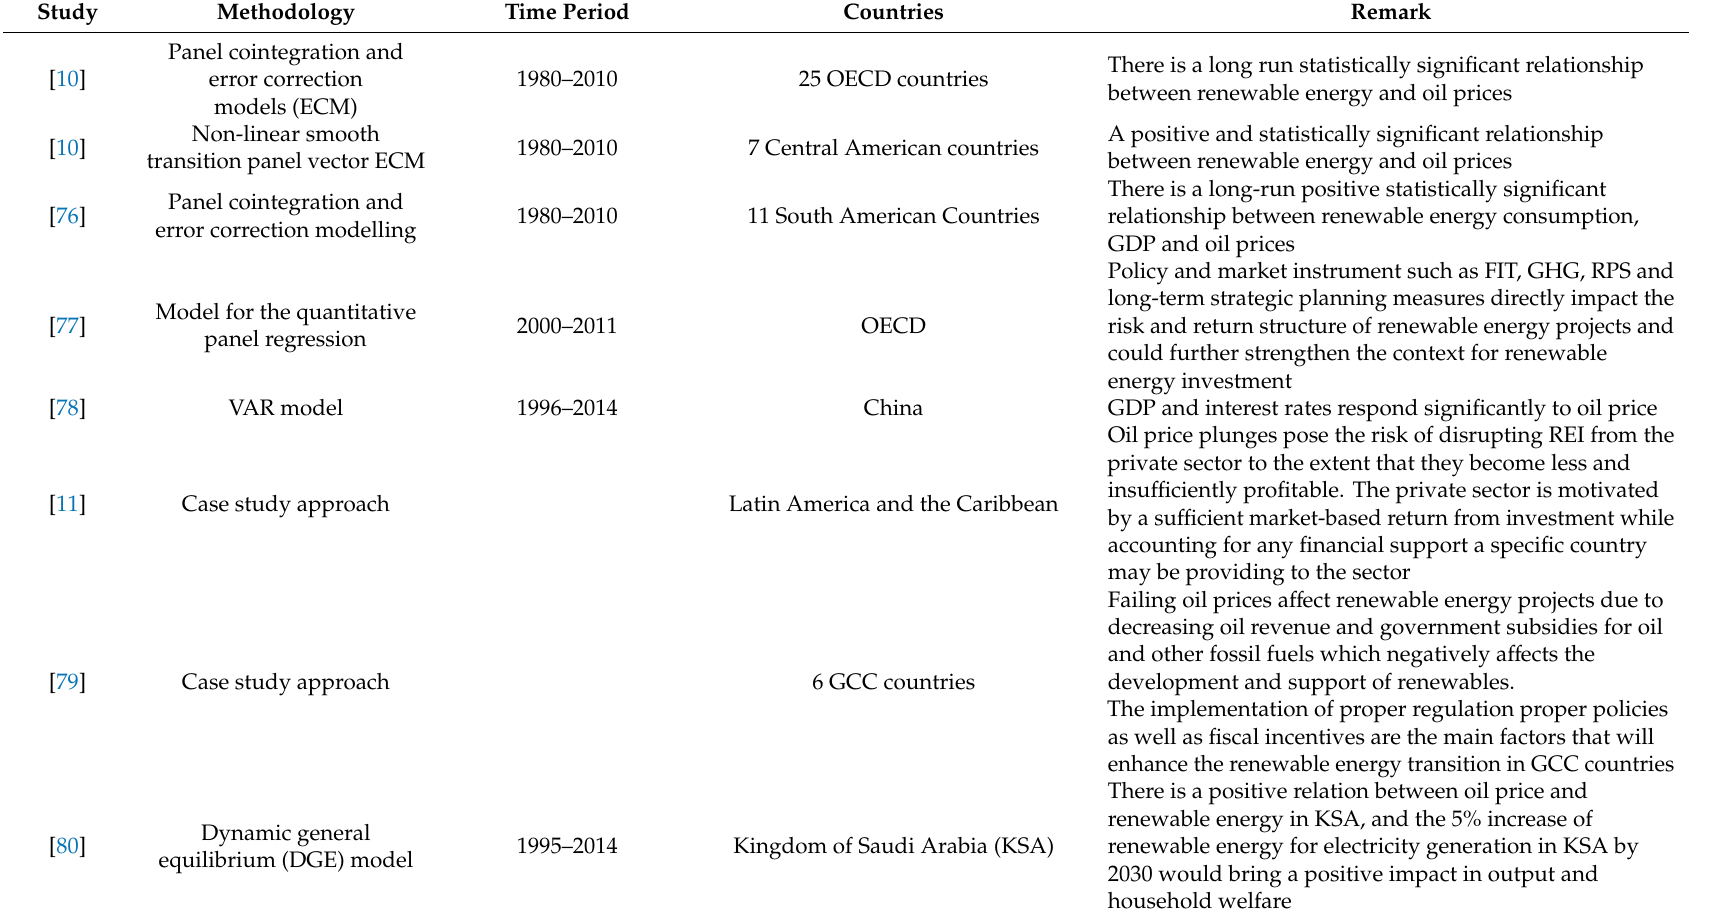
Table 1. Review of the recent literature on fossil fuel price and renewable